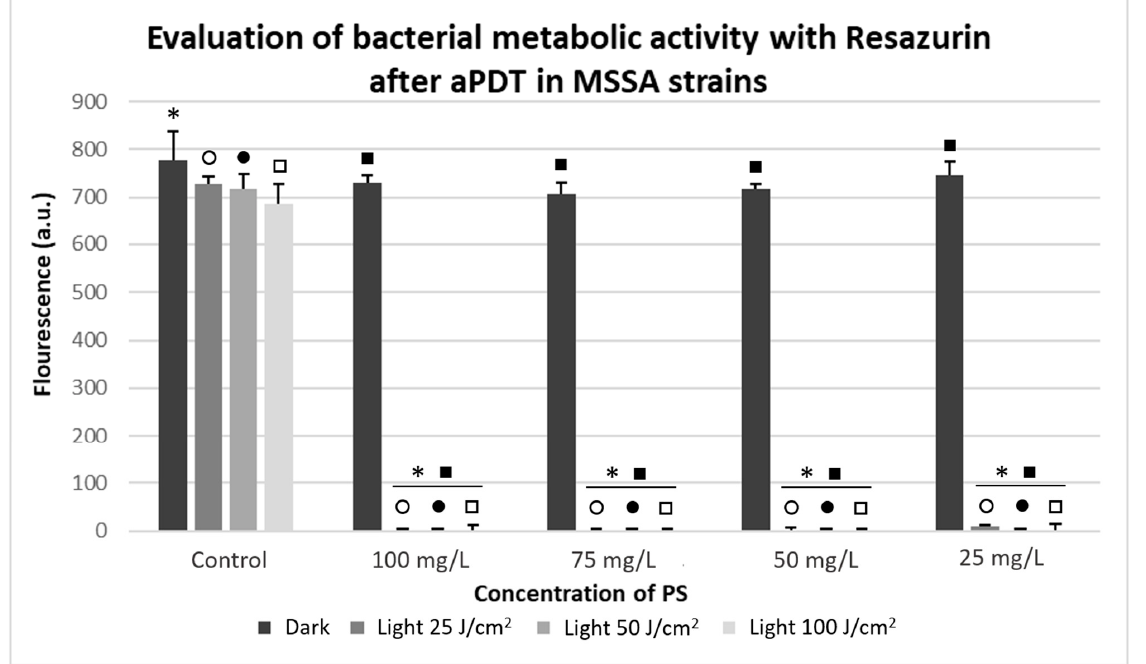
Figure 6. Evaluation of bacterial metabolic activity with Resazurin in arbitrary fluorescence units for MSSA strains, showing Dark and Light control groups; Photodithazine ® at 25, 50, 75, and 100 mg/L; and non-irradiated and irradiated groups with fluences of 25, 50, and 100 J/cm 2 . * Significant differences were observed between the Dark Control group to 100, 75, 50, and 25 mg/L with Dark, light 25, 50, and 100 J/cm 2 groups. ○ Significant differences were observed between the light 25 J/cm 2 Control group to 100, 75, 50, and 25 mg/L with light 25 J/cm 2 groups. ● Significant differences were observed between the light 50 J/cm 2 Control group to 100, 75, 50, and 25 mg/L with light 50 J/cm 2 groups. □ Significant differences were observed between the light 100 J/cm 2 Control group to 100, 75, 50, and 25 mg/L with light 100 J/cm 2 groups. ■ Significant differences were observed between the Dark 100, 75, 50, 25 mg/L groups to 100, 75, 50, and 25 mg/L with light 100, 75, 50, and 25 J/cm 2 groups.